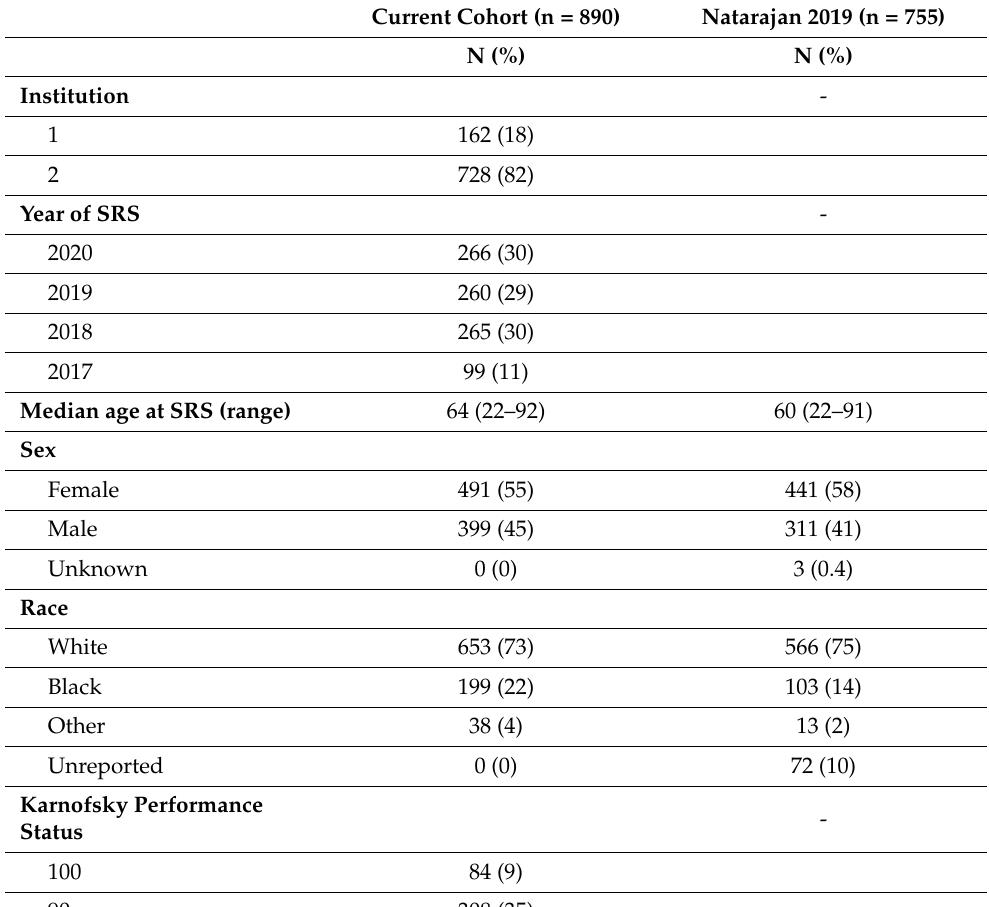
Table 1. Patient demographics and disease characteristics across all patients. Abbreviations: In- terquartile range, IQR; stereotactic radiosurgery, SRS; non-small cell lung cancer, NSCLC; small cell lung cancer,